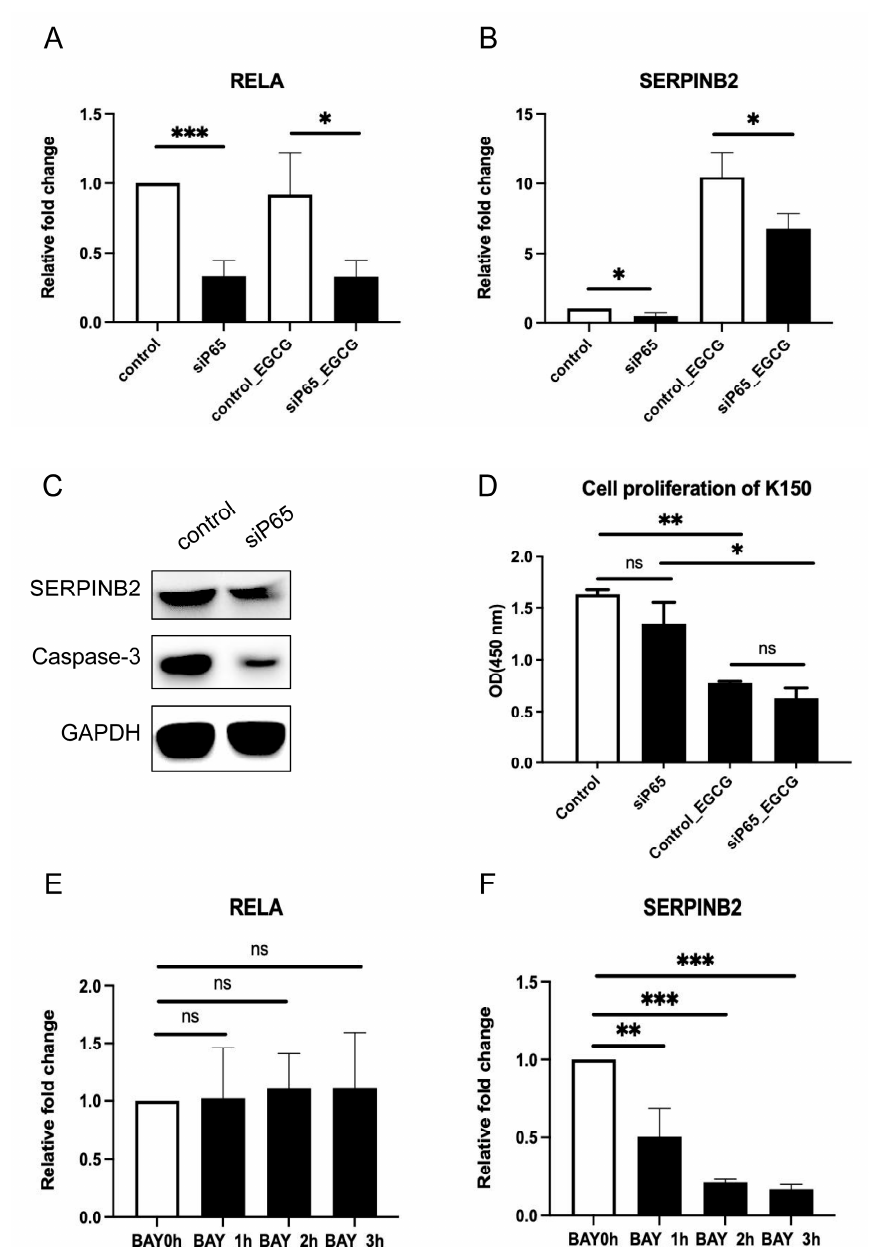
Figure 6. p65 regulates the expression of SERPINB2 in KYSE150 cells. ( A , B ) Relative fold change of RELA ( A ) and SERPINB2 ( B ) after p65 knockdown with or without EGCG. ( C ) Western blotting showing protein levels of SERPINB2 and Caspase-3 after p65 knockdown. ( D ) Cell proliferation after p65 knockdown. ( E , F ) Relative fold change of RELA ( E ) and SERPINB2 ( F ) expression after p65 inhibition. Data are shown as mean ± SD. n = 3, *: p < 0.05; **: p < 0.01; ***: p < 0.001, ns: not significant.